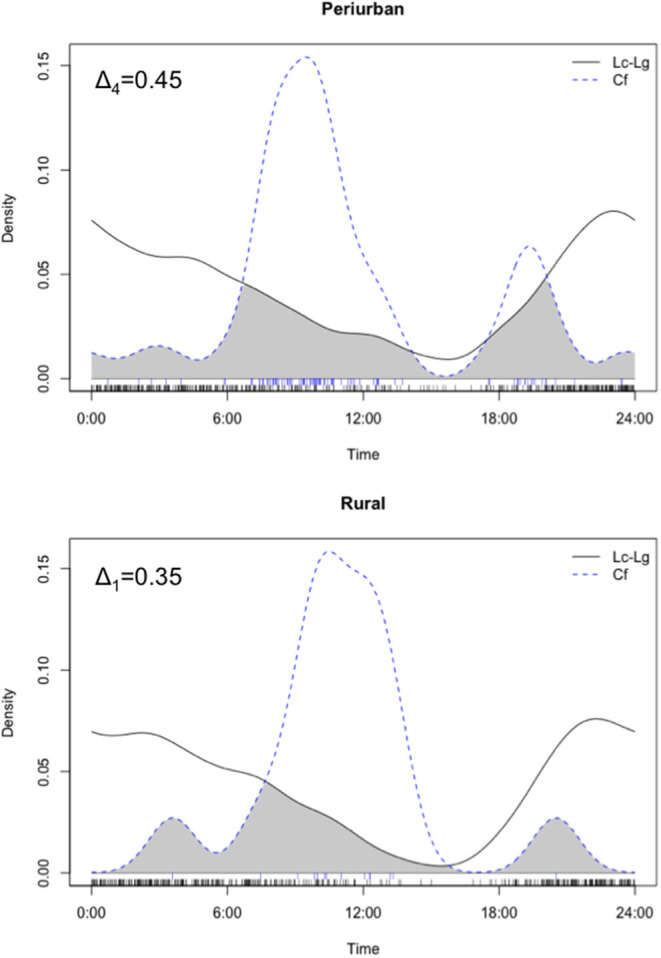
Density estimates of temporal activity displayed by culpeo (Lc) and chilla (Lg) foxes (solid line) and domestic dogs (Cf) (dashed line) in the periurban and rural sites in austral spring and summer between 2018 and 2020. Activity overlap between species is represented by the gray shaded area between lines. Deltas (Δ4 and Δ1) correspond to the coefficients of overlap. Fox activity is represented by combined photos of culpeo and chilla foxes. Data in the wild site are not graphed.